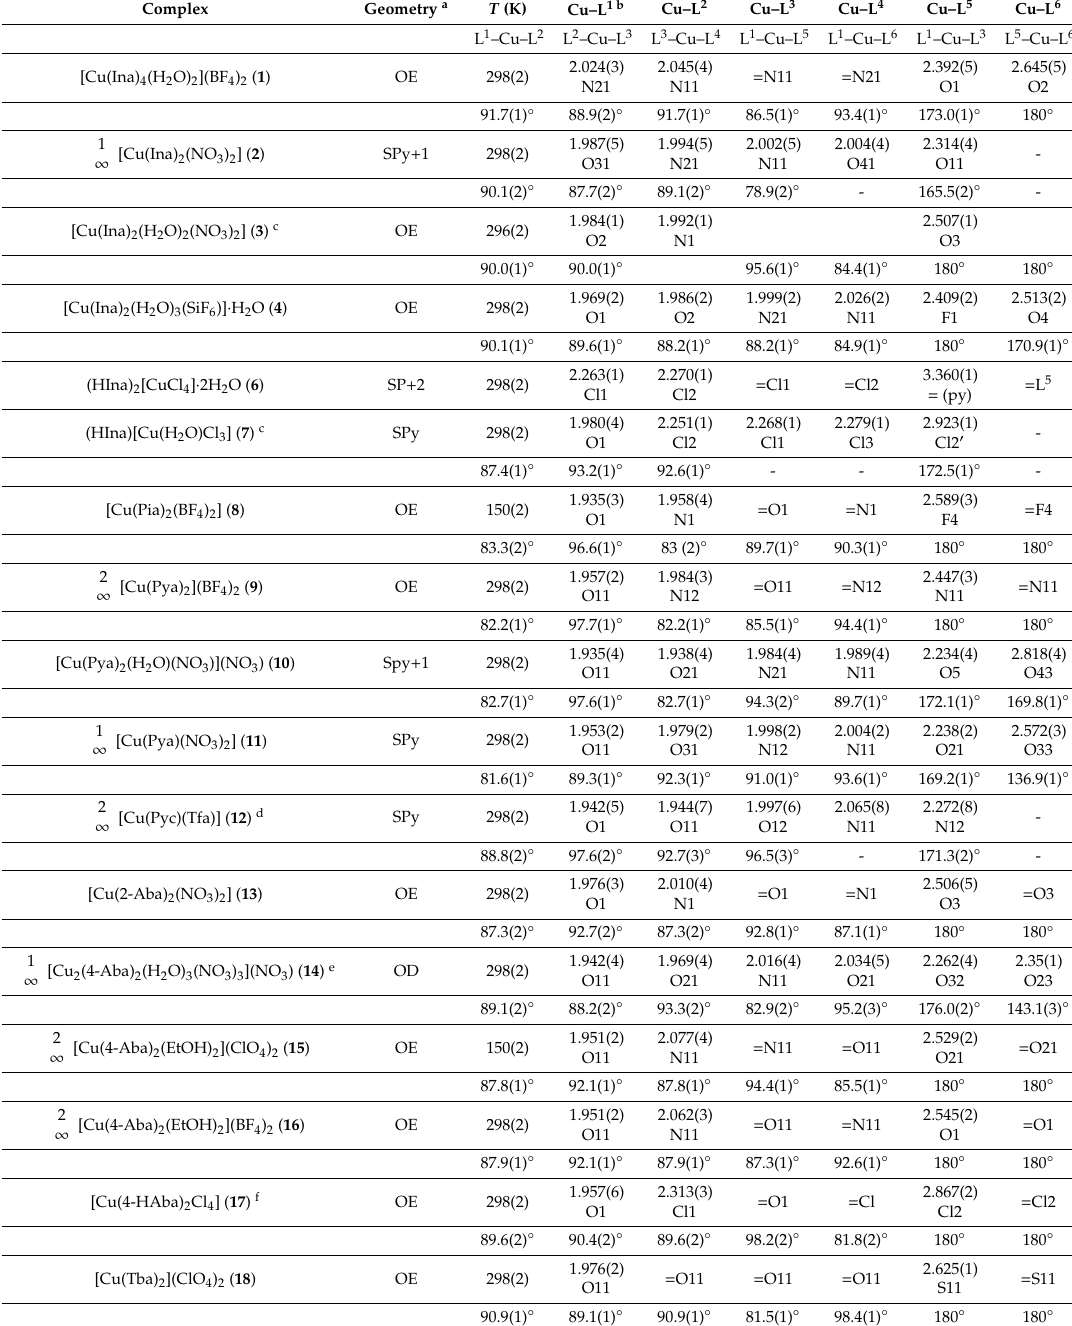
Table 2. Selected binding parameters (distances in Å, angles in ◦ ) around the Cu II centres.